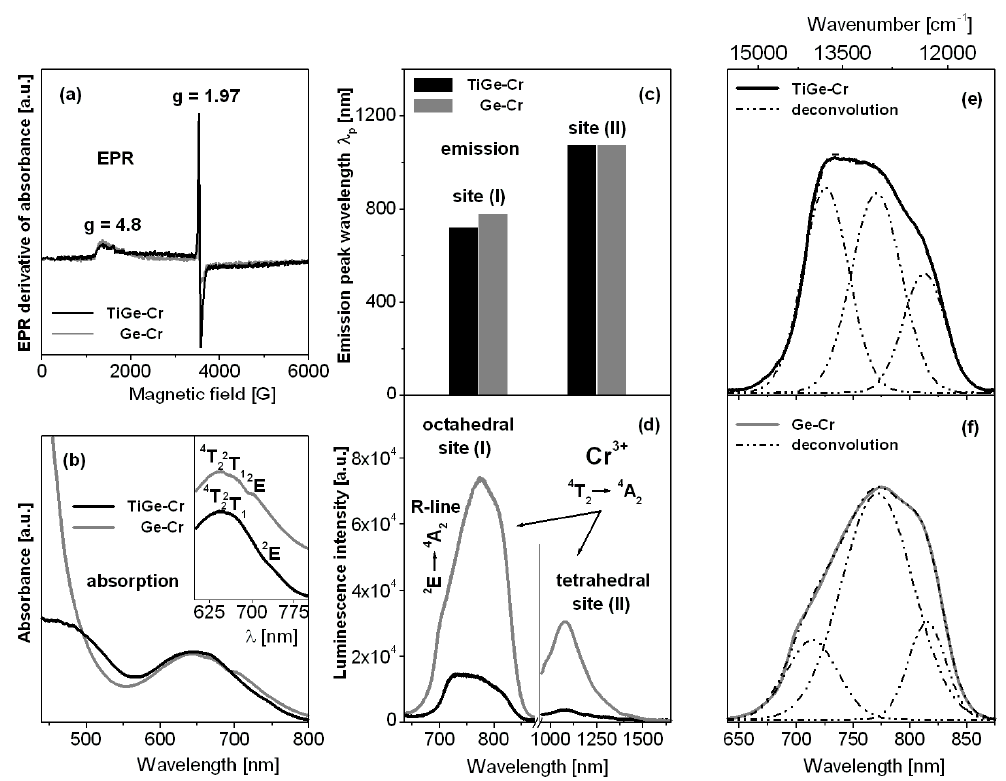
Figure 2. EPR ( a ), absorption ( b ), and luminescence ( c , d ) spectra measured for titanate-germanate glasses doped with chromium ions (TiGe-Cr) and compared to glass samples without TiO 2 (Ge-Cr). Deconvoluted emission bands for both glass samples TiGe-Cr ( e ) and Ge-Cr ( f ) are also given. The near-infrared luminescence spectra of chromium ions revealed two emission bands, but both well observed lines are assigned to the transition originating from the 4 T 2 excited state to the 4 A 2 ground state. According to the excellent paper published recently, the near-infrared emission bands centered at about 730 nm and 1030 nm are related to the 4 T 2 → 4 A 2 transitions in octahedral sites (I) and tetrahedral sites (II) of chromium ions [37]. Further spectroscopic analysis indicates that the intensities of luminescence bands are stronger for chromium ions located at octahedral site (I) than tetrahedral site (II). The maximum of emission peak wavelength for the 4 T 2 → 4 A 2 transition of chromium ions in octahedral sites (I) is changed from 730 nm (Ge-Cr) to 775 nm in the presence of titanium dioxide (TiGe-Cr) in contrast to tetrahedral site (II), where both peak maxima are the same. Furthermore, the profiles of emission bands associated to transition of chromium ions in site (I) are completely different. It is especially evidenced for the 2 E → 4 A 2 transition commonly known as R-line, which is overlapped with the 4 T 2 → 4 A 2 transition of chromium ions in octahedral site (I). The maximum of R-line is shifted to longer wavelength from 715 nm (Ge-Cr) to 727 nm (TiGe-Cr). In order to further study the structural changes occurring in the arrangement around Cr 3+ , the emission bands were successfully deconvoluted into three Gaussian components. The luminescence band ascribed to the 4 T 2 → 4 A 2 transition was well divided into the red and the blue components, confirming the coexistence of two completely different site distributions for chromium ions. During the deconvolution procedure, peak wavenumber ( ν ), linewidth (d ν ), the energy gap between both 4 T 2 and 2 E excited states ∆ E = E( 2 E) − E( 4 T 2 ), and the relative integrated emission line intensities I ( 2 E) / I ( 4 T 2 ) = A R-LINE / (A RED + A BLUE ) and I ( 2 E) / I TOTAL ) = A R-LINE /(A RED + A BLUE +A R-LINE ) were estimated. The A RED + A BLUE + A R-LINE denotes the integrated emission intensities of the red and the blue components